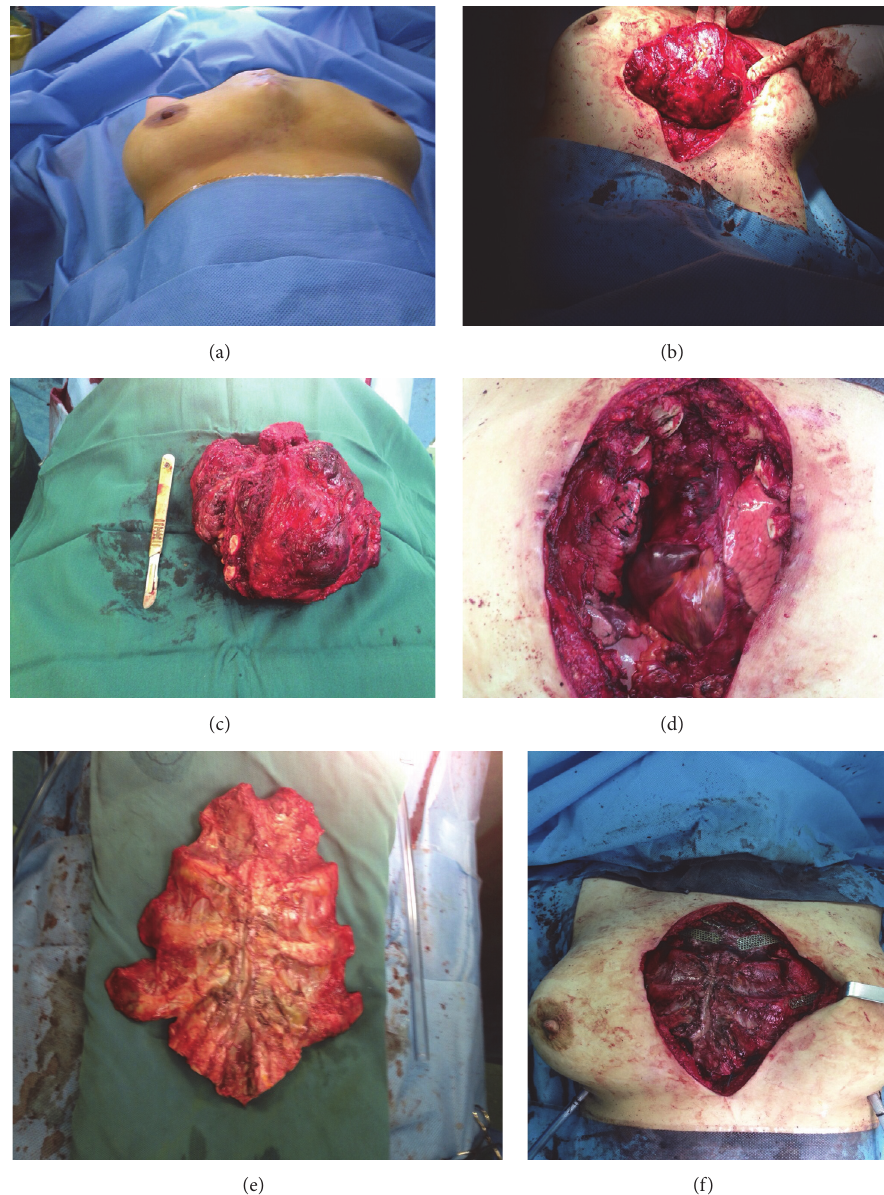
Figure 2: Preoperative picture of patient with a large bulging in anterior mediastinal area (a). At the time of operation a large hemorrhagic mass without obvious invasion to surrounding tissues was discovered (b) that was completely resected along with sternal manubrium (c). Large anterior defect of chest wall (d) was reconstructed by a cryopreserved sternal allograft (e) that was fixed by titanium plates and screw